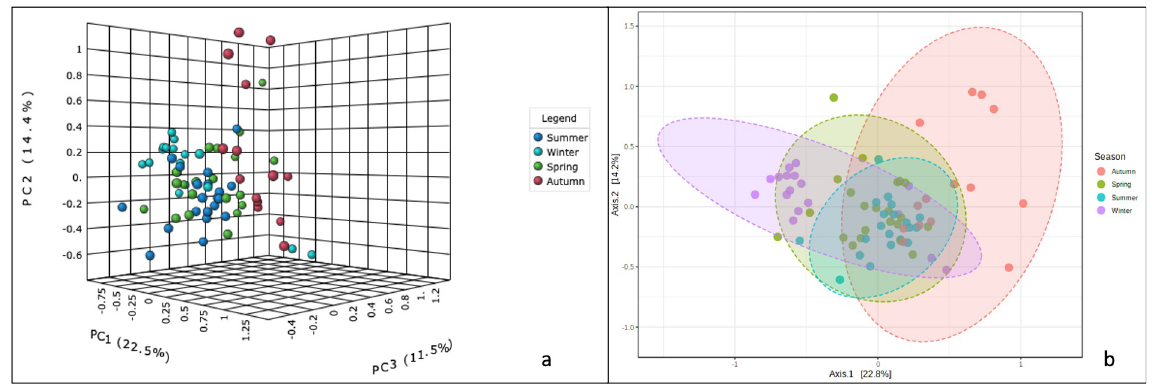
Fig 13. Community structure profiling of nasal bacterial communities across four seasons. (a) 3D and (b) 2D PCoA plots. Beta diversity PCoA plots were obtained by applying the ANOSIM algorithm on the Bray Curtis distances of bacterial genera. Four partially overlapping clusters representing the seasons (colors specified in the legends on the right-hand side